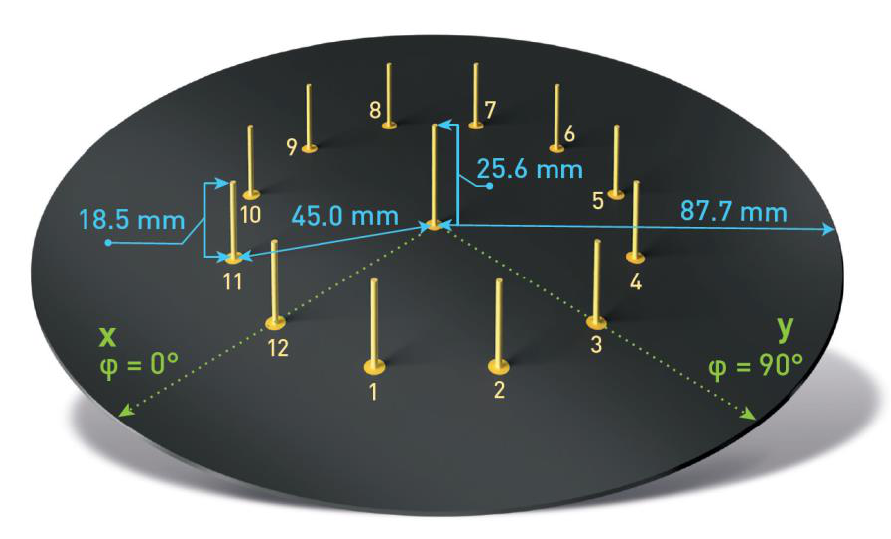
Figure 1. Electronically steerable parasitic array radiator (ESPAR) antenna design.